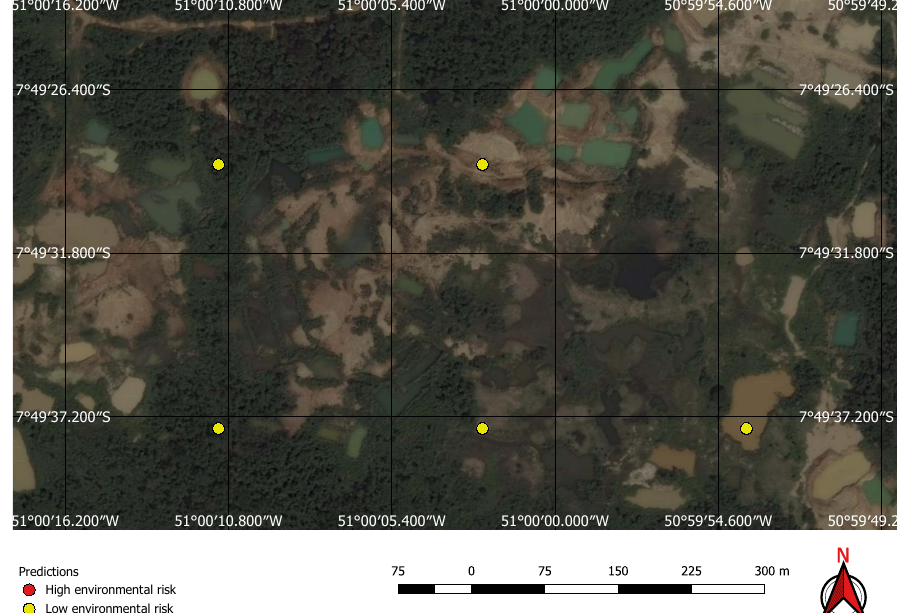
Figure 17. Detail of a discovered mining spot on the Kayapo’s protected